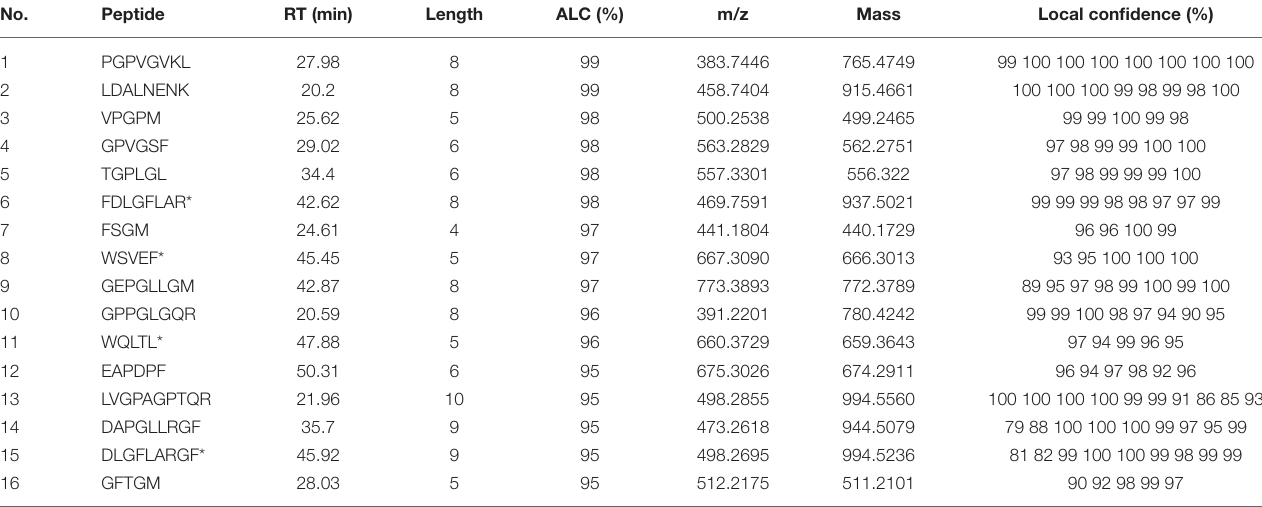
TABLE 3 | Identification of peptides unique to PAT by LC–ESI–Q–Orbitrap–MS/MS.